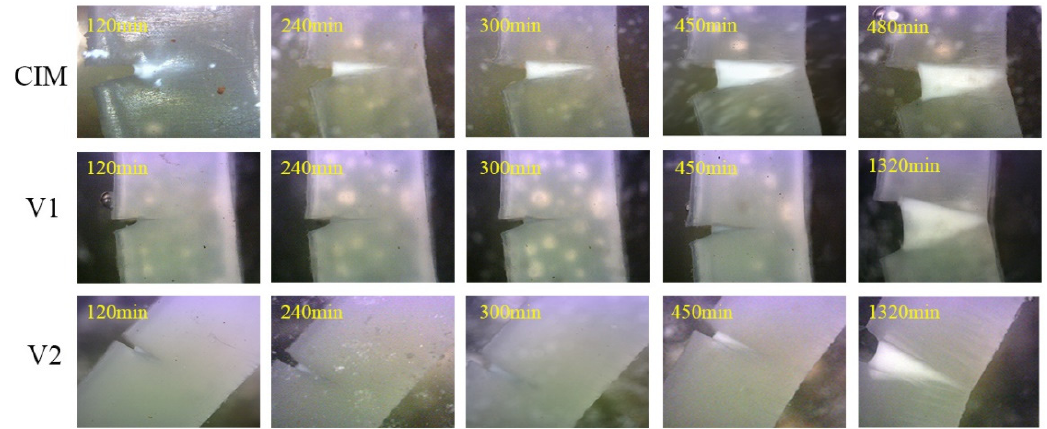
Figure 5. The patterns of the crack growth of specimens under a low initial stress for different times at 50 °C.